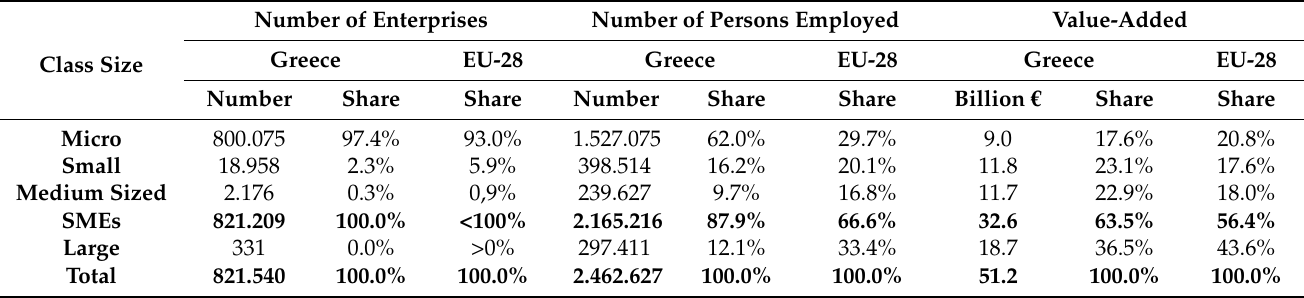
Table 1. Enterprises/Class size, 2019.